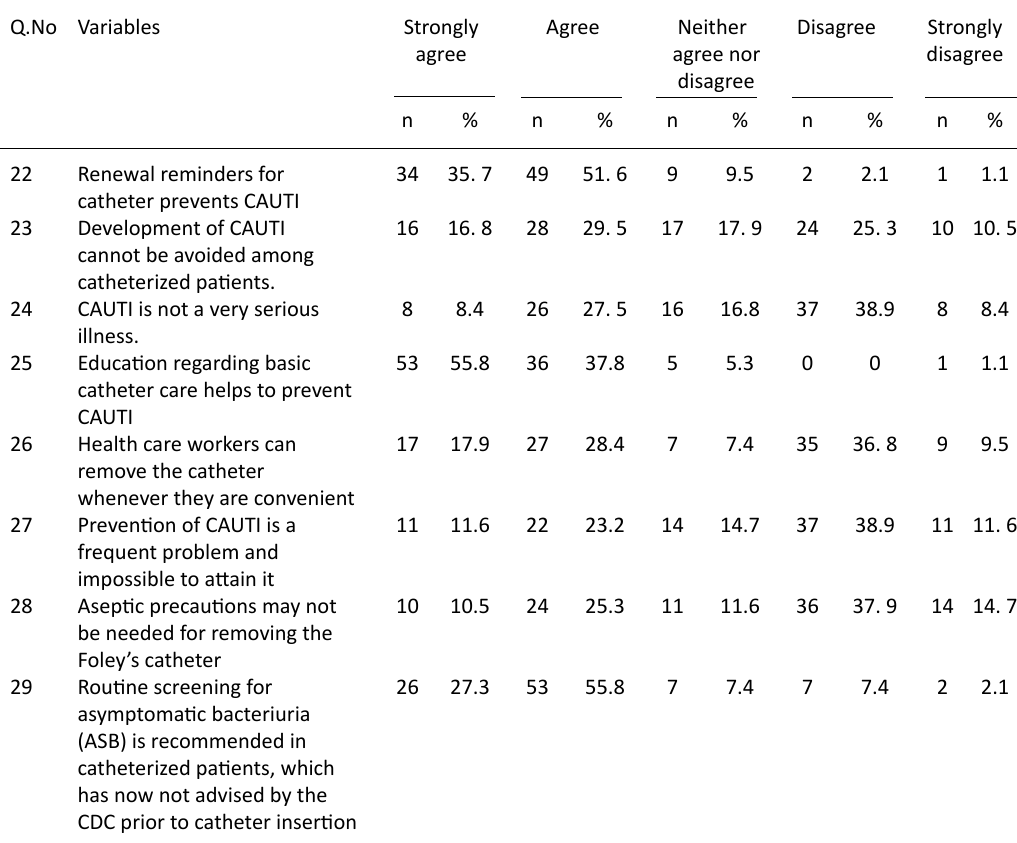
Table 4. Assessment of Attitude towards prevention of CAUTI among health care professionals (n=95) Q.No